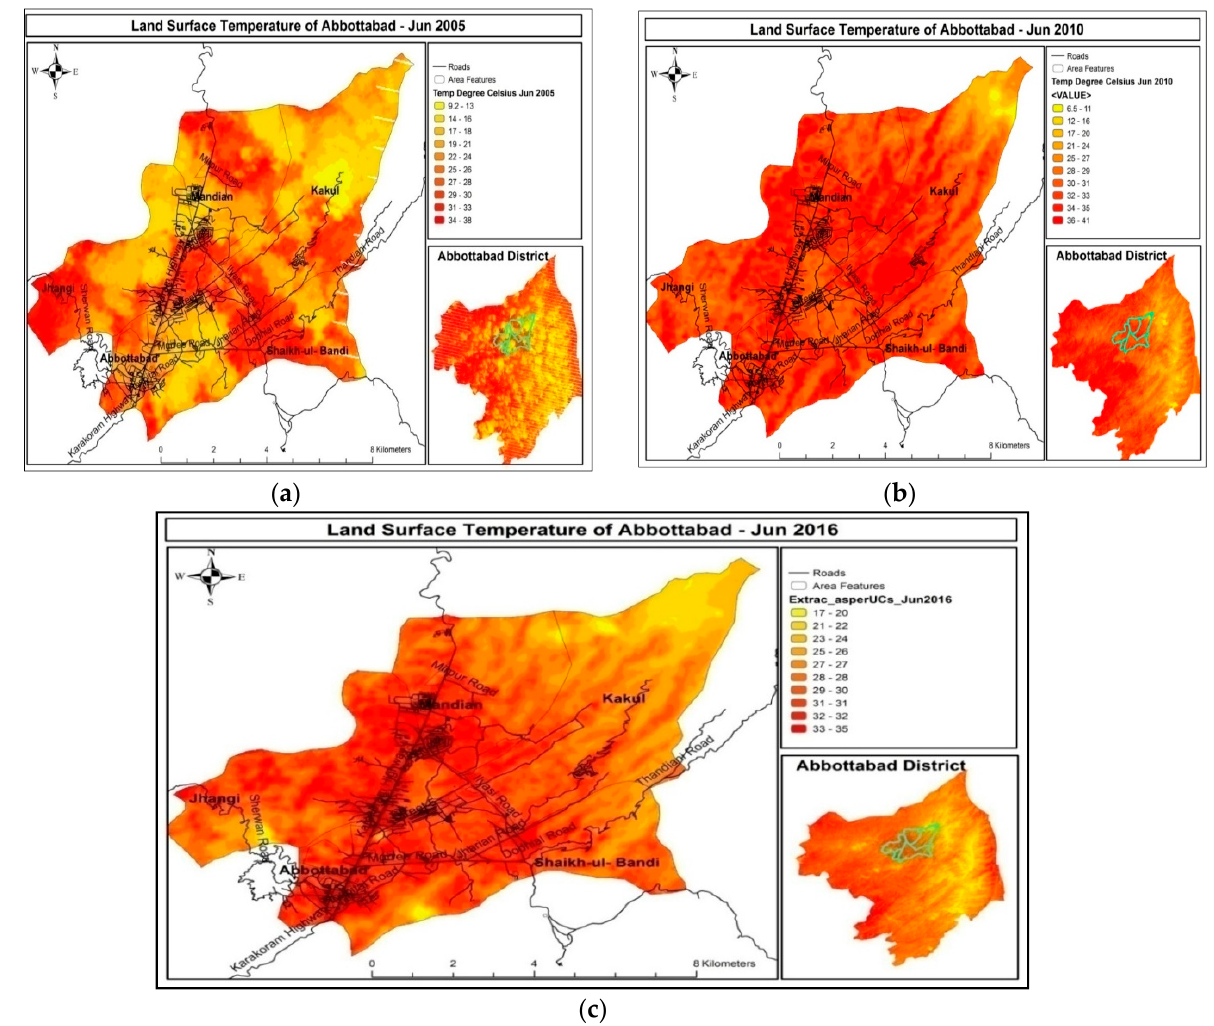
Figure 12. ( a ). LST of Abbottabad from Jun 2001–2005 ( b ) LST of Abbottabad from Jun 2006–2010 ( c ) LST of Abbottabad from Jun 2011–2016.